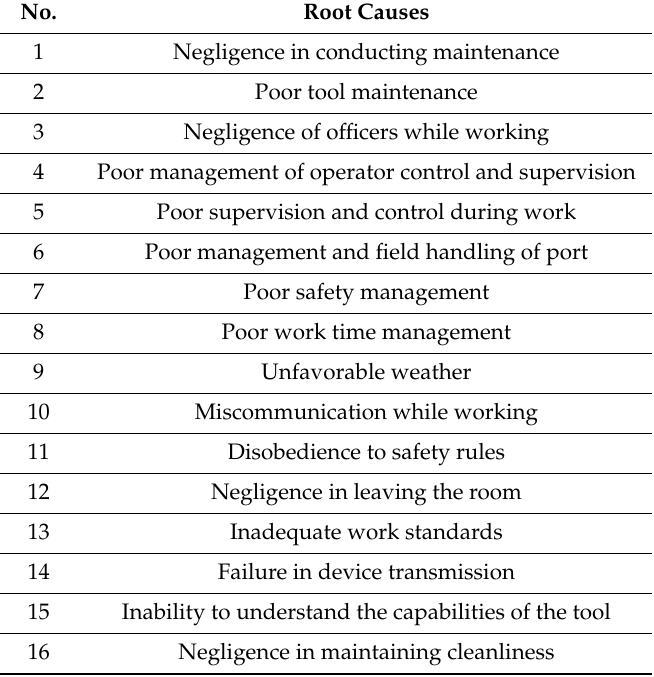
Figure 7. FTA of Environmental Pollution. Table 12. Root causes of high-risk